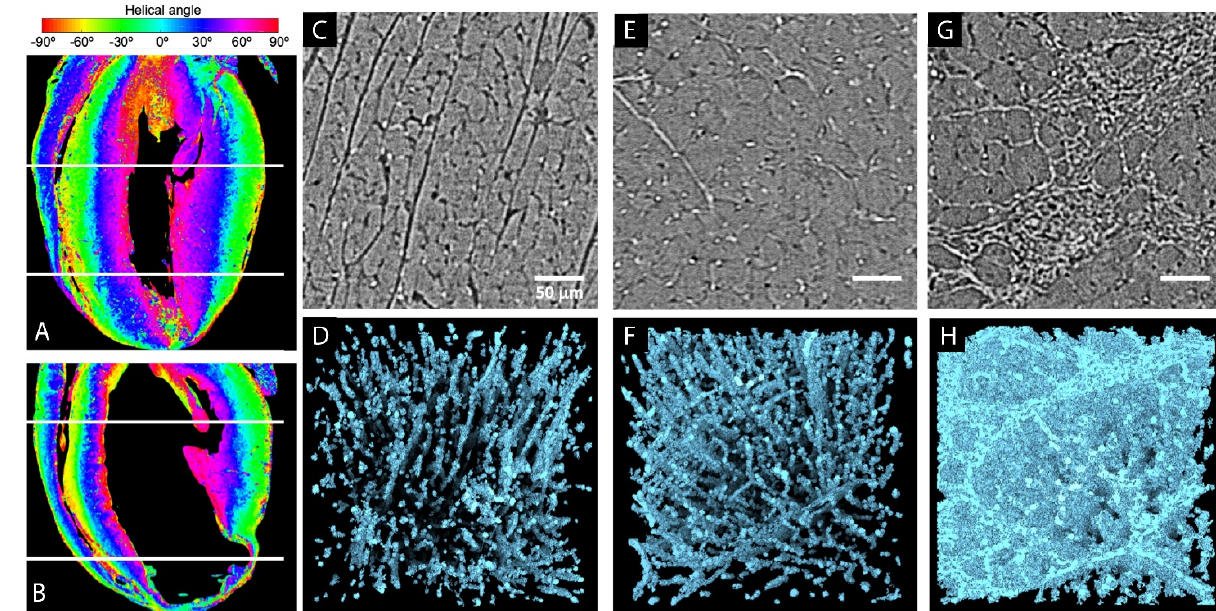
Figure 3. Extraction of the fiber orientation in rat hearts based on PC-CT . First column: quantification of the orientation of myocyte aggregates in ( A ) WKY and ( B ) LAD hearts: ventricular helical angle maps in four chambers view. White dashed lines were used for additional illustrations. Last three columns: collagen segmentation in high-resolution images. ( C – G ) Representative PC-CT image slices from subvolumes in the left ventricular septum of the WKY, SHR and ISO hearts, respectively. ( D – H ) 3D rendering of collagen segmentation in the same subvolumes, visually showing the increase in density and change in shape and distribution around the tissue. Scar tissues can be seen in the ISO specimen. ISO: isoproterenol-treated rats, LAD: left anterior descending artery ligation model, SHR: spontaneously hypertensive rat and WKY: Wistar Kyoto rat model (adapted from and with kind permission from Reference [31], licensed under the Creative Commons Attribution 4.0 International License [95]).